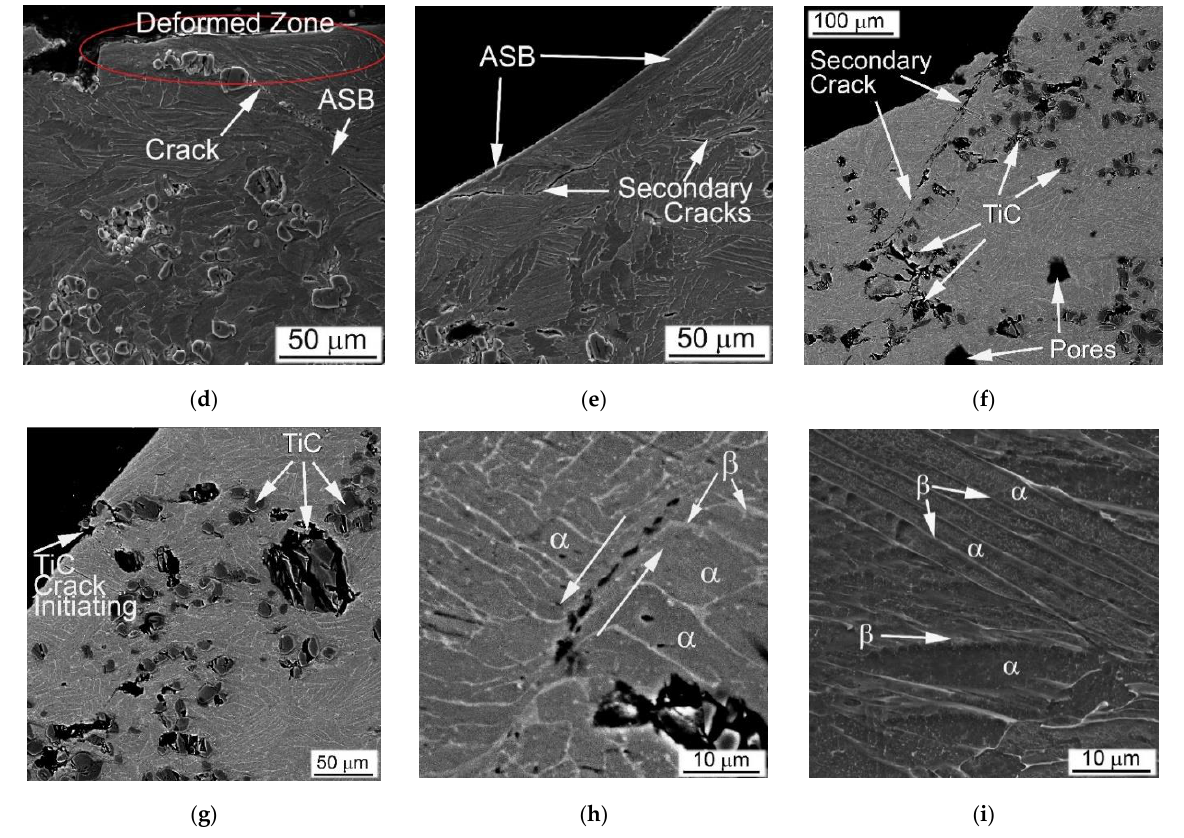
Figure 10. Typical fracture surface ( a – c ) and microstructure ( d – i ) of Ti64BEPM + 5TiC MMC SHPB tested at 2040 s − 1 strain rate. Arrows in ( a , c ) indicates directions of cracks growth. ( d ) Zone I, ( e – g ) Zone II; ( h ) Zone III ( i ) Zone IV. SEM, ( a – d , g , i ) SE, ( e , f , h ) BSE. ( f , g , h ) polished; ( d , e , i ) polished and etched. Images ( d – i ) are aligned with their vertical axis along with the acting external load like in Figure 8.